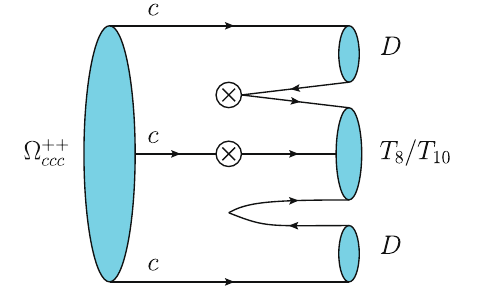
Fig. 2 The Feynman diagrams for (cid:2) ++ ccc decays into two D -mesons and a light baryon (octet or decuplet)